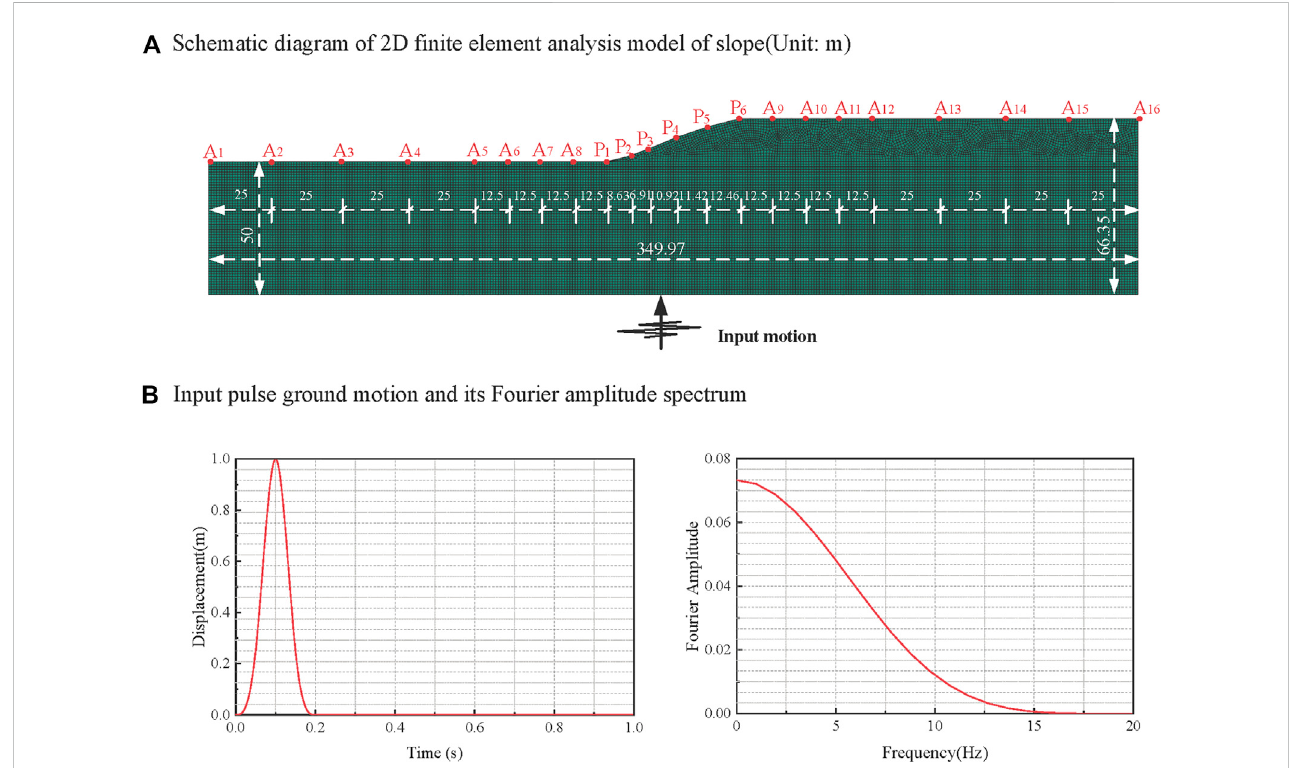
FIGURE 4 Finite element model of the slope site and the input